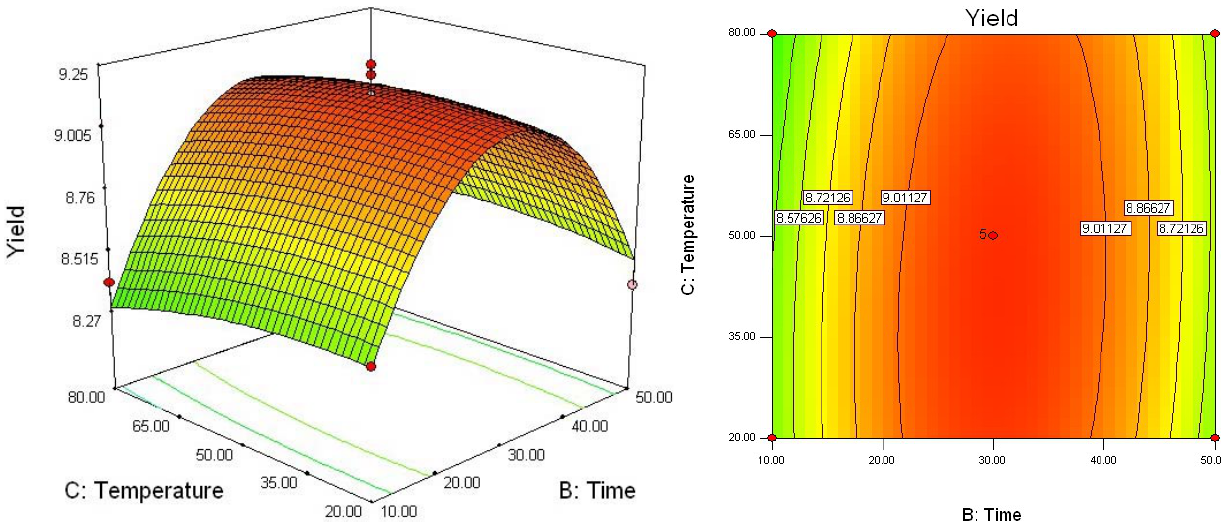
Figure 4. Response surface plot of extraction temperature and extraction time.